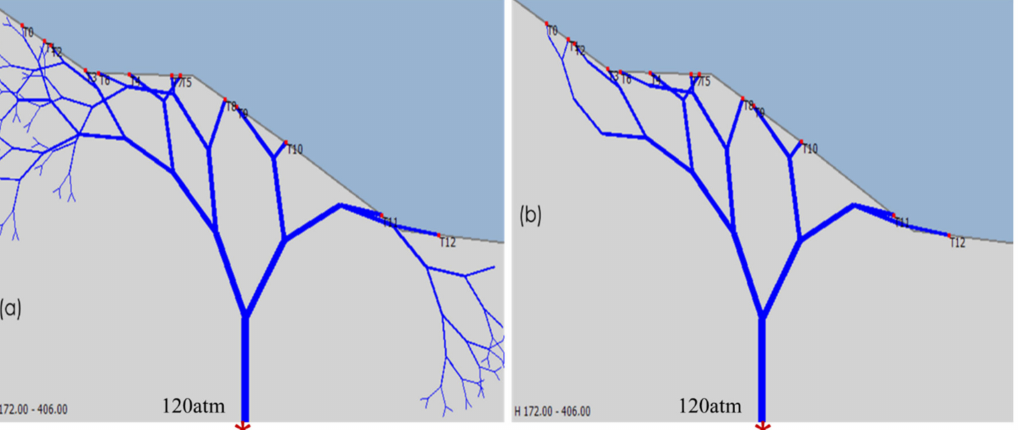
Figure 11. Computer simulation program for modeling groundwater pressure maps in fractured rocks: ( a ) dilution procedure; cracks that do not go out are excluded; ( b ) all cracks come to the